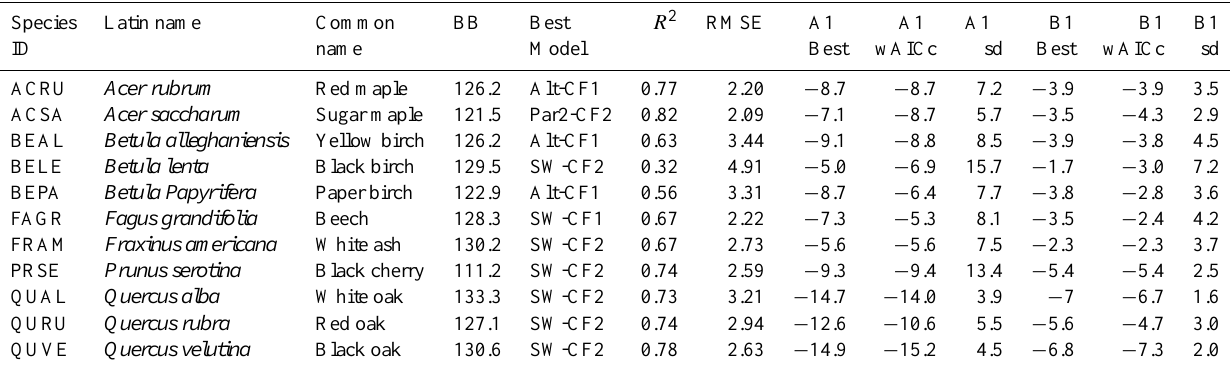
Table 1. List of the 11 species used in the analysis, species identifier (Species ID), species Latin and common name, average bud-burst date (BB), best model according to data (Best Model), coefficient of determination ( R 2 ), root mean square error (RMSE, day), Sen’s slope trend estimated for scenario A1fi and scenario B1 with the best model, with the Akaike Weigthed average (Average wAICc) and the standard deviation. All trends are expressed in daycentury − 1